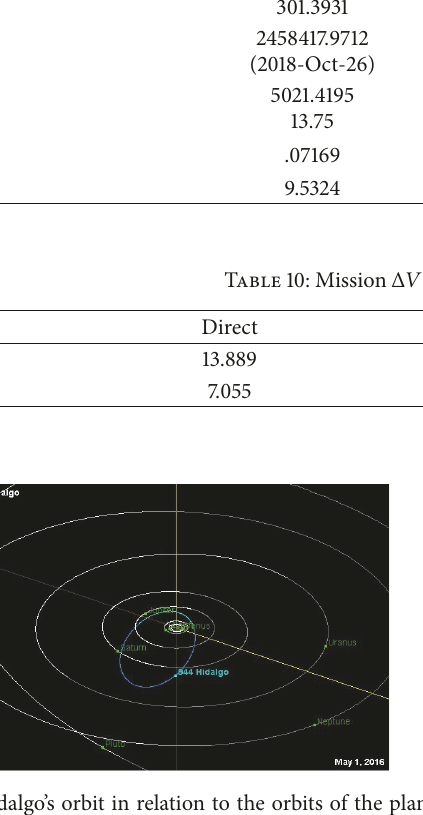
Figure 8: Hidalgo’s orbit in relation to the orbits of the planets as referenced on 1 May 2016.